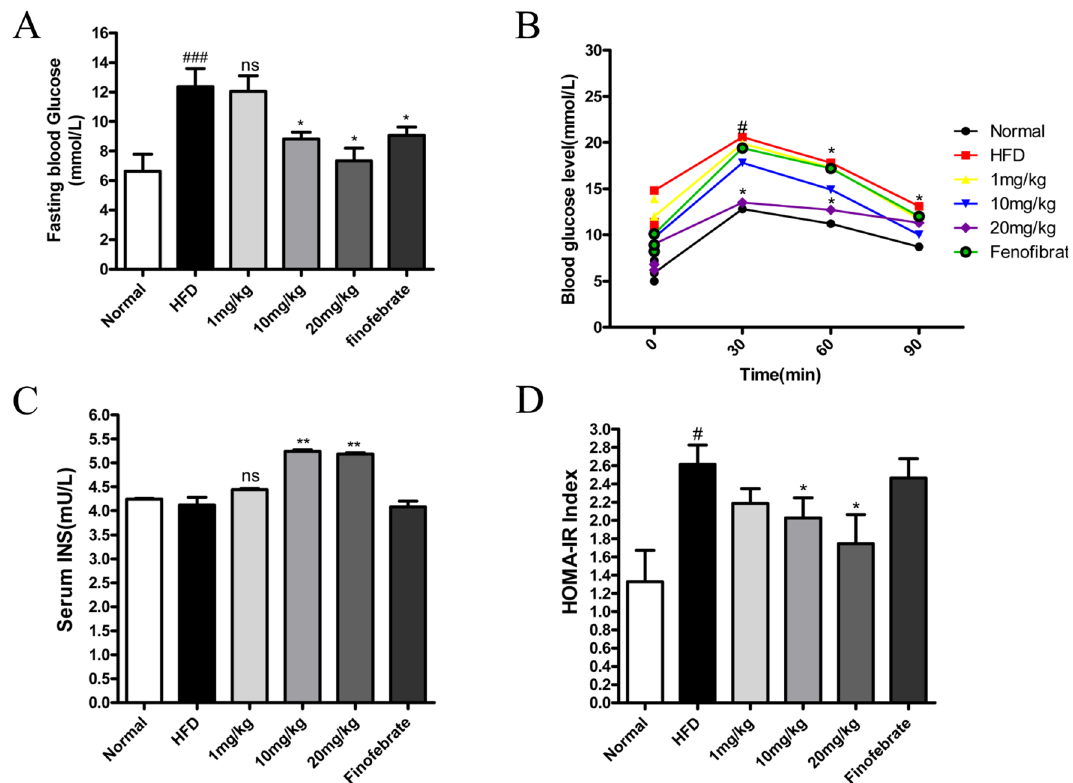
Figure 3. Effect of STVNa on IR in HFD-induced NAFLD. ( A ) The content of fasting blood glucose. ( B ) IPGTT was conducted to determine the effect of STVNa on glucose metabolism. ( C ) Serum of insulin content. ( D ) HOMA-IR indices. After 5 weeks of STVNa intervention, the HFD-fed rats had an enhancement in HOMA-IR scores ( P < 0.05). Mean ± SEM. * P < 0.05, ** P < 0.01 vs. HFD-fed rats; ## P < 0.01, ### P < 0.001 vs. ND-fed